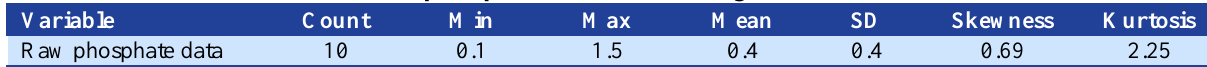
Table 1. Basic statistics of the raw phosphate data and the log-transformed data Variable